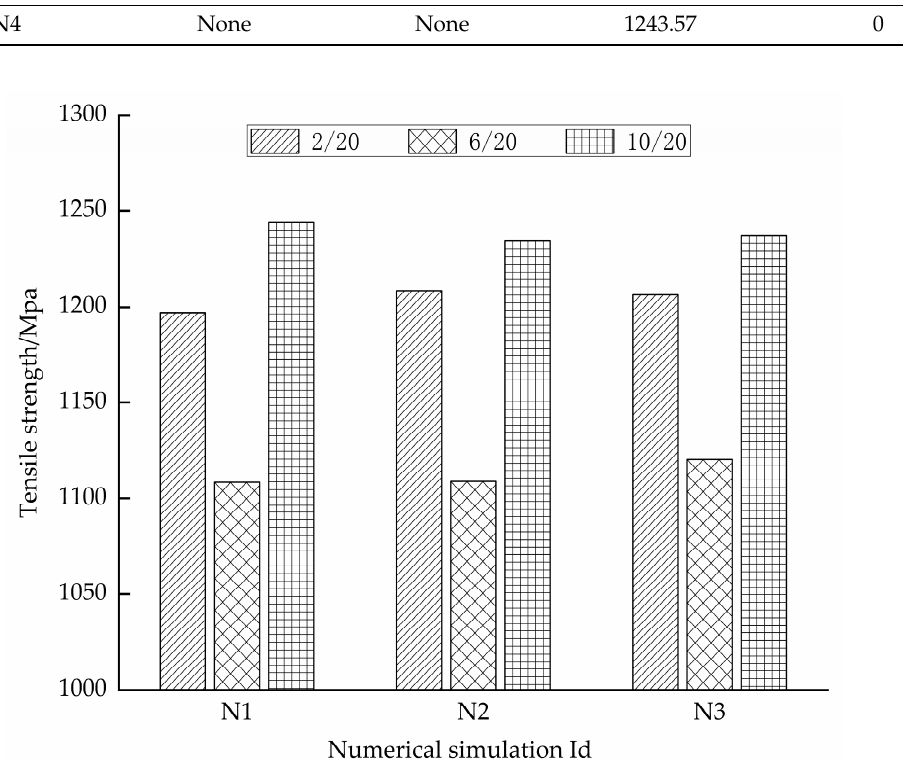
Figure 14. Tensile strength of the predicted